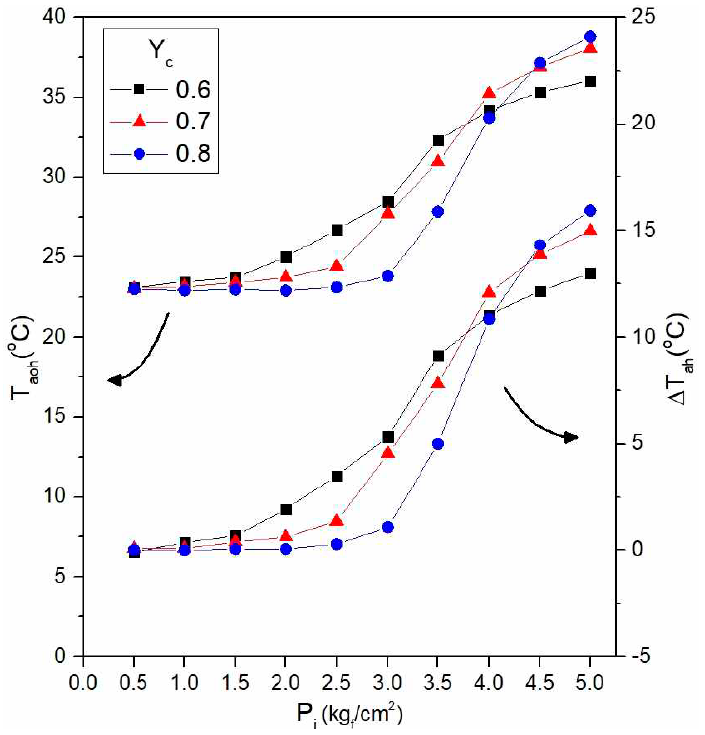
Figure 24. Indirect heat exchange method of ∆ T h according to pressure.